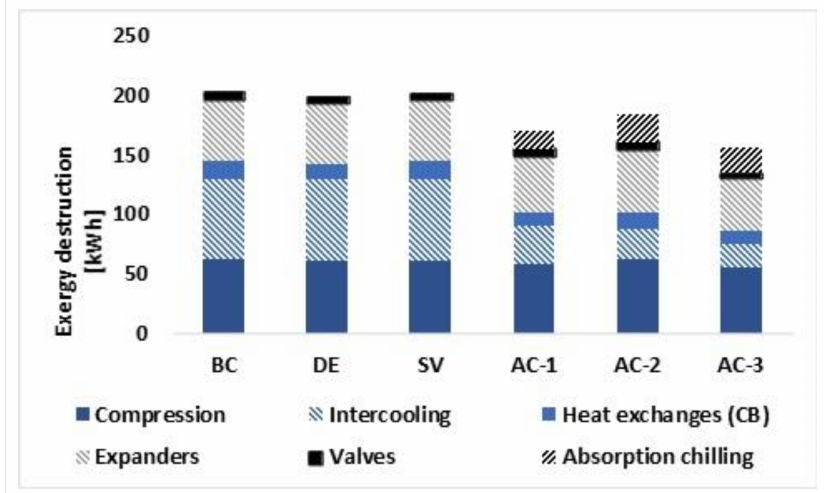
Figure 17. Exergy destruction for the various cases. Different colors refer to different elements of the system.